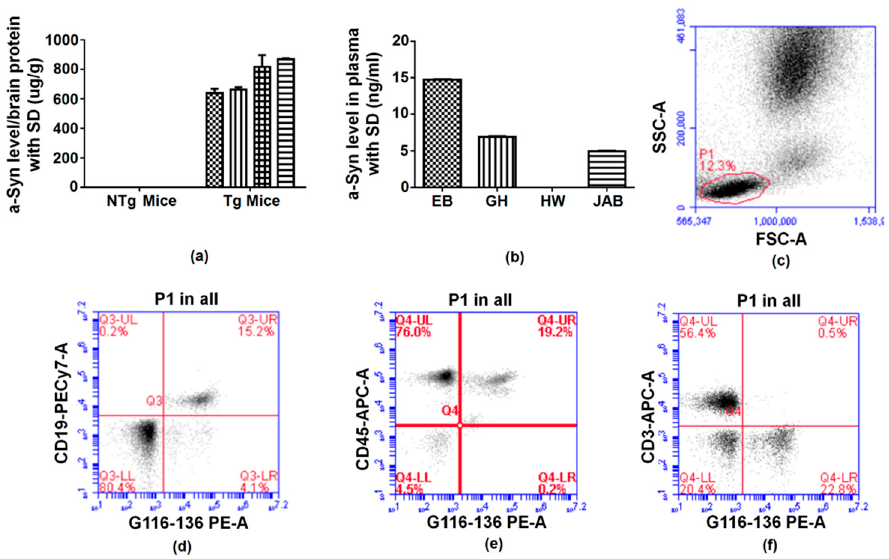
Figure 3. Application of antibodies. ( a ) Capture ELISA detection of human α -synuclein levels in soluble brain protein lysates of transgenic (4 Tg mice samples) and non-transgenic (4 nTg mice samples) mice by G116-136 antibody detection. ( b ) Capture ELISA result of human α -synuclein levels in 4 human plasma samples (EB, GH, HW, JAB). ( c – f ) Immunophenotyping result using flow cytometry to measure CD19+/ α -syn, CD45+/ α -syn, and CD3+/ α -syn cell populations. The application of antibodies in ELISA and flow cytometry could help quantify α -syn levels in human blood and transgenic mice brain samples, as well as aid research focusing on finding potential biomarkers for PD diagnosis in the future.